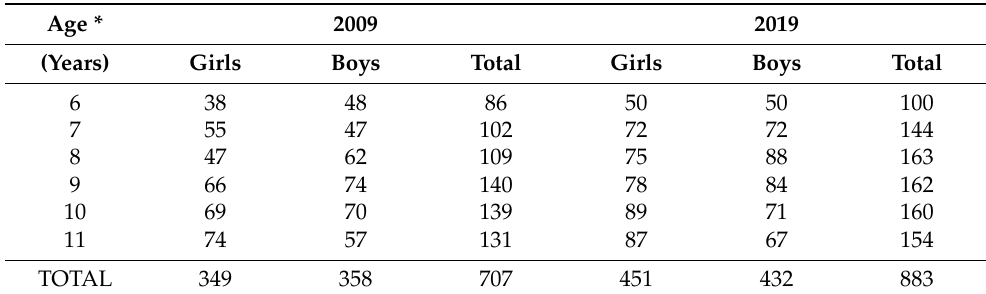
Table 1. Sample size by sex, age, and study cohort.